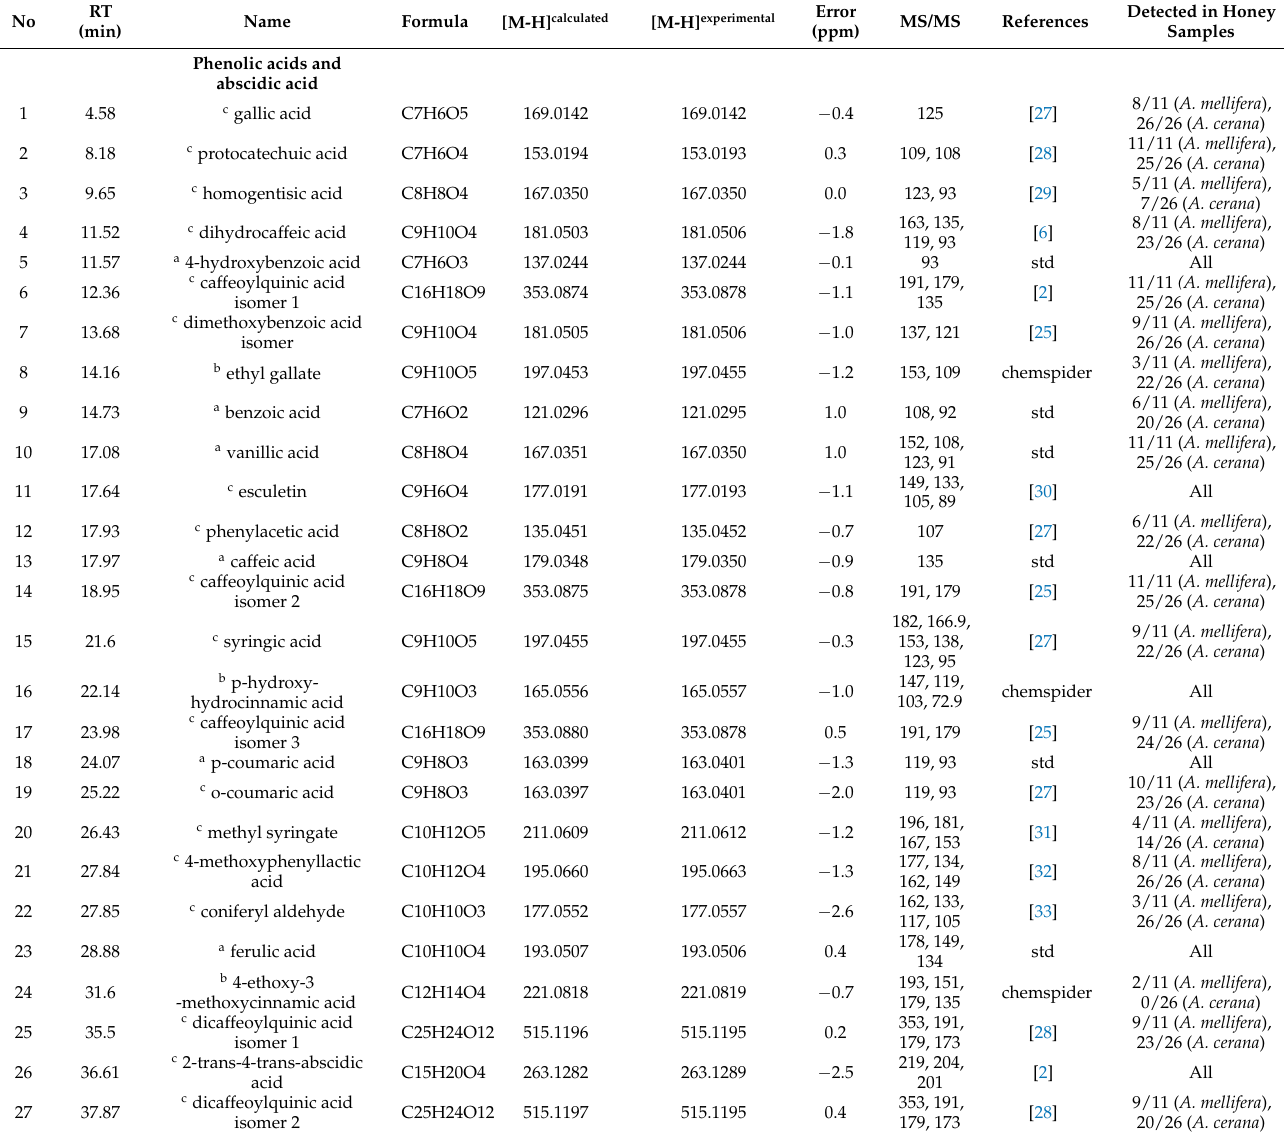
Table 3. High resolution MS data and fragmentation of phenolic compounds identified in A. cerana and A. mellifera